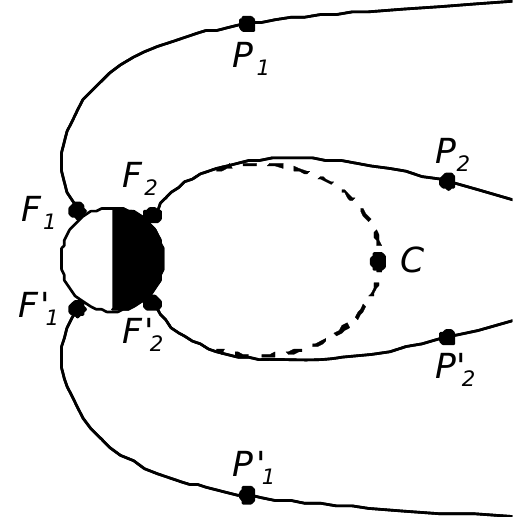
Fig. A1. Schematic tail lobe magnetic field lines near noon- midnight plane (solid lines; not to scale) and a “reconnected” field line (dashed; tailward moving counterpart not drawn). Letters F and F’ denote field line intersection with Earth’s surface (see text).